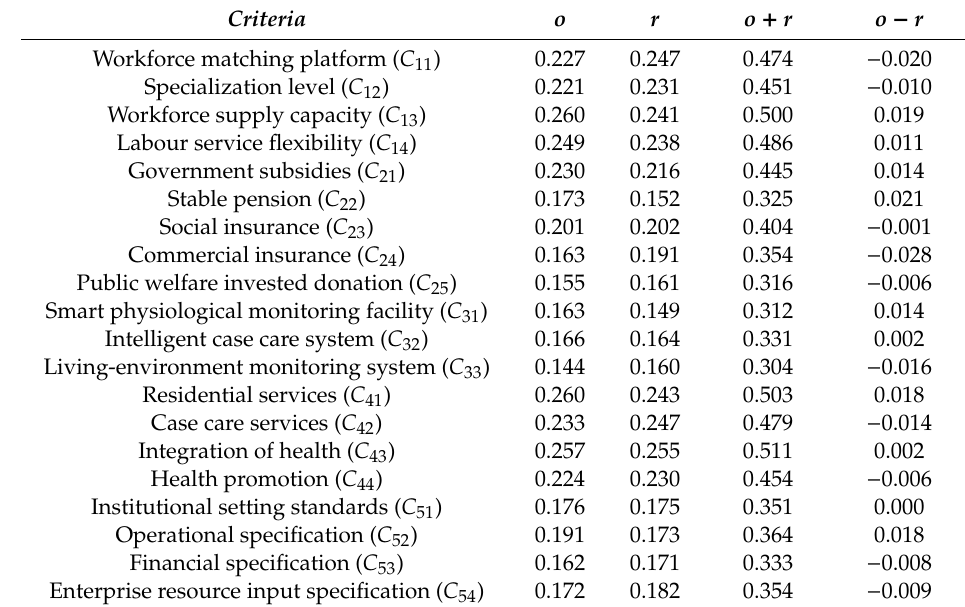
Table A5. Sum of influences given / received on